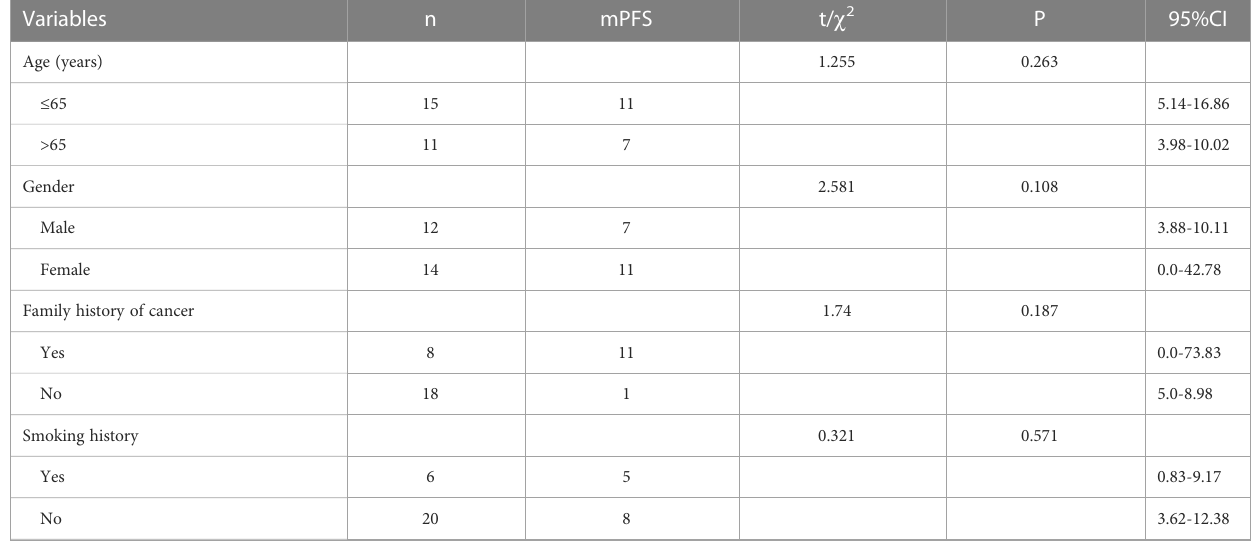
TABLE 2 Univariate analysis of